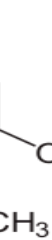
Figure 1. The chemical structure of thymol.